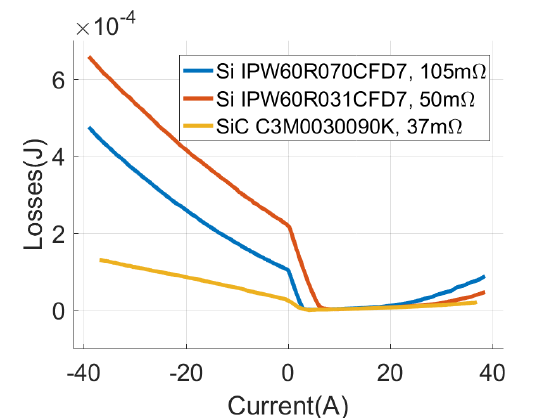
Figure 4. Switching losses in HV switches for the three MOSFET alternatives listed in Table 1 at 270 V switching voltage and Tj = 100 ◦ C